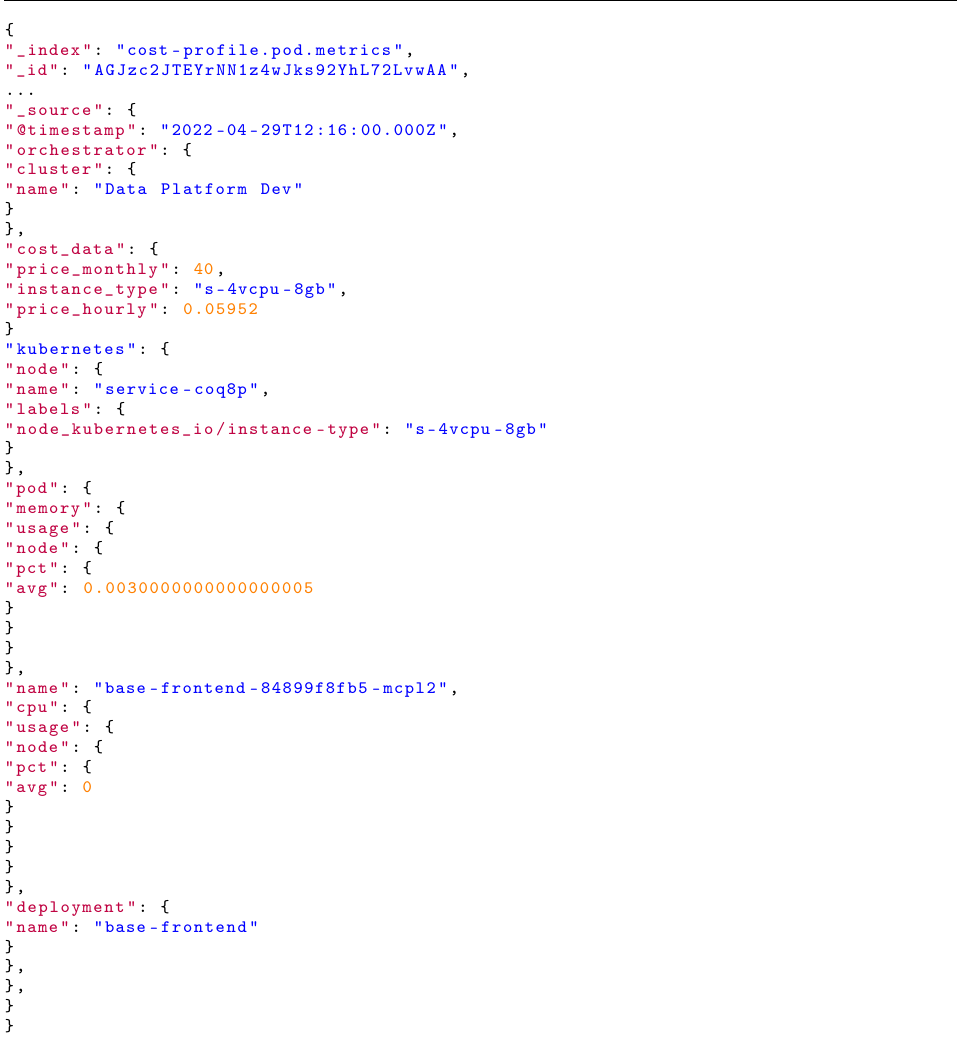
Figure 4 shows a small part of the result of a successful deployment of the tool for the data platform under consideration after having collected data for a few days and visualized them in its dashboard. The dashboard builds on the capabilities offered by Kibana and extends the default APM-oriented view offered out-of-the-box by the Elastic Stack. Different graphs are provided for different pieces of information. For example, in the bottom part of the figure, the relative node utilization is plotted as a series of stacked bar plots. The aggregated utilization per node for both memory and CPU is shown in the middle of the figure. Cost-profiling-related information is visualized in the top half of the dashboard, including the total cost of the target application both per hour and cumulatively over time. The graphs plot the costs per (microservice) deployment both independently for each deployment and as stacked bars to indicate the overall cost. Each of these graphs is interactive, allowing for filtering and zooming in to each of the data series plotted (e.g., microservice deployment). The visualized data can also be dynamically subsetted to specific time intervals for more targeted analysis of the visualizations, and any graph can be removed or moved around on demand. The tool repository has more information on the capabilities of the dashboard as part of its